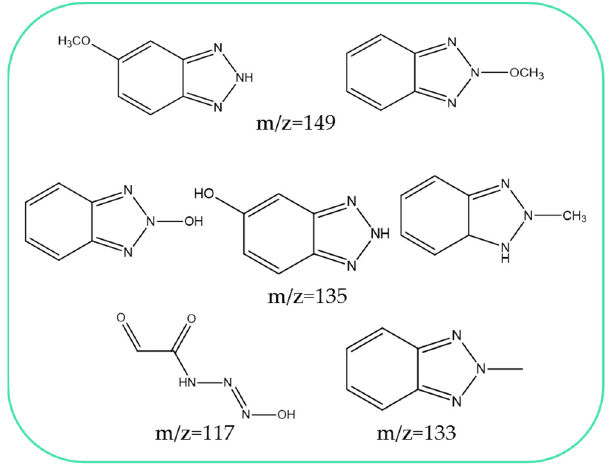
Figure 8. Proposed structures of benzotriazole UV stabilizers’ oxidation products.